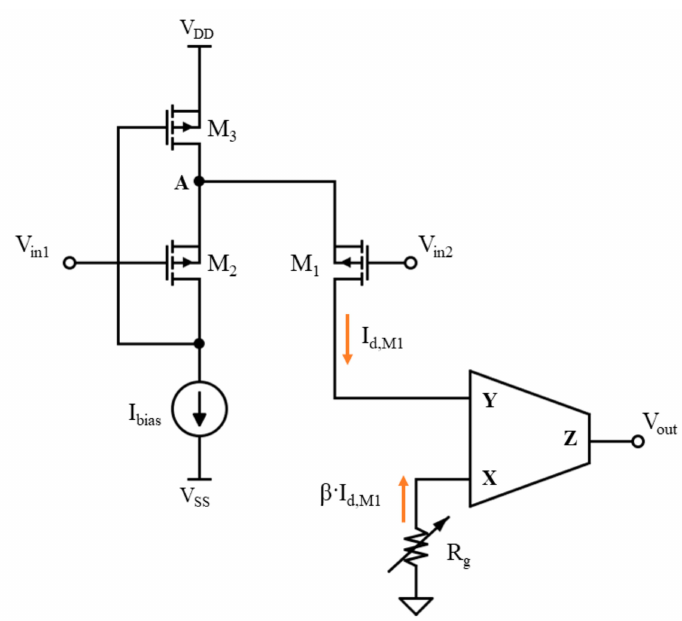
Figure 4. Mixed circuit and block scheme of the proposed DFVF-VCII-based